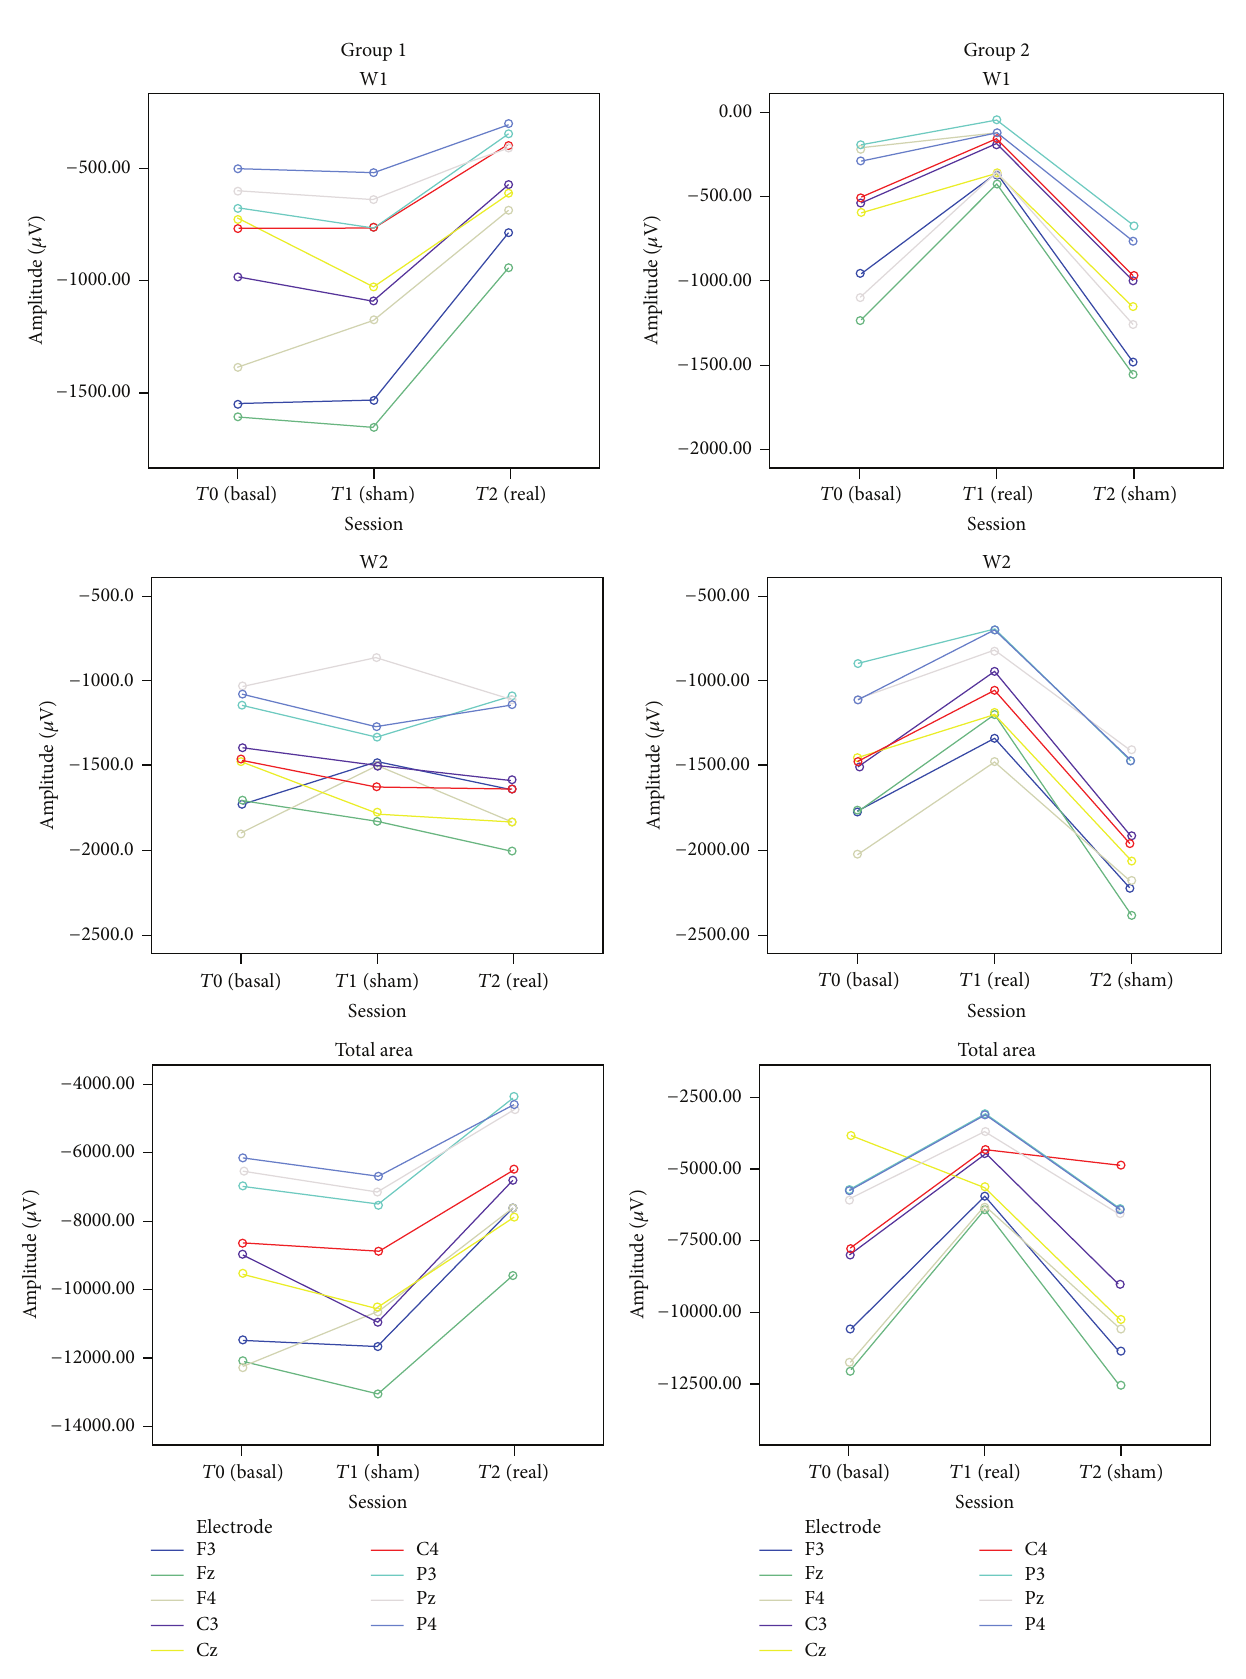
Figure 3: Mean amplitudes of early CNV (W1), late CNV (W2), and total CNV area across the active electrodes in basal condition, post-real rTMS, and post-sham rTMS for group 1 and group